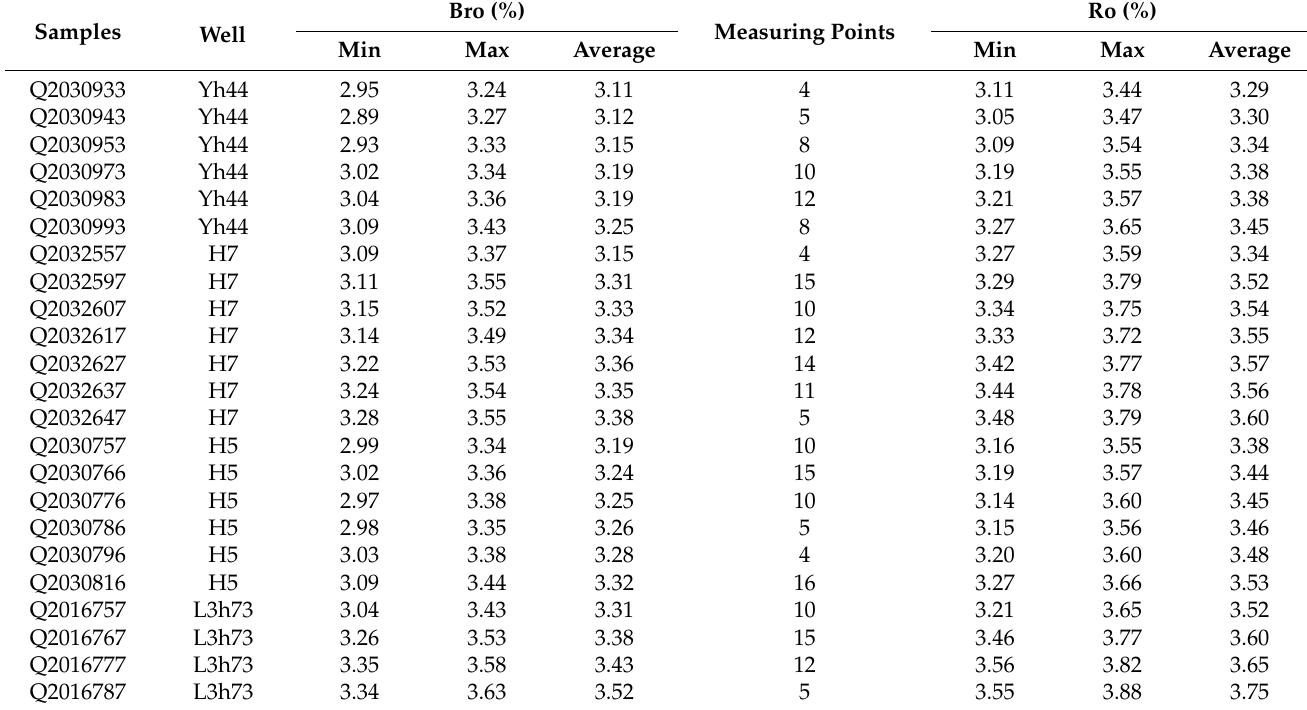
Table 4. Statistical table of shale asphalt reflectance and vitrinite reflectance of the Longmaxi Forma- tion shale in the study